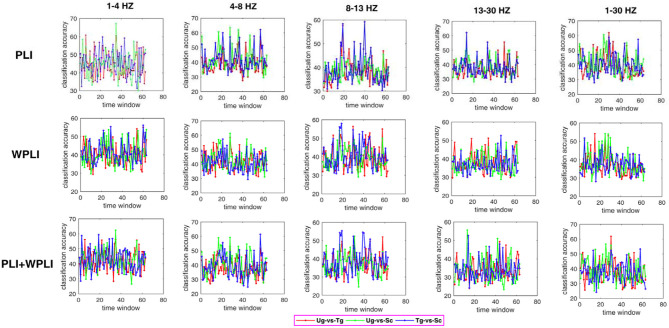
Classification accuracies in different time windows. The subfigure 1–5 are the classification results that applied graph metrics which obtained by using the PLI to construct brain network in five bands, subfigure 6–10 are the results obtained by WPLI on the same conditions as 1–5, and subfigure 11–15 are the results that calculated by combining both PLI and WPLI.